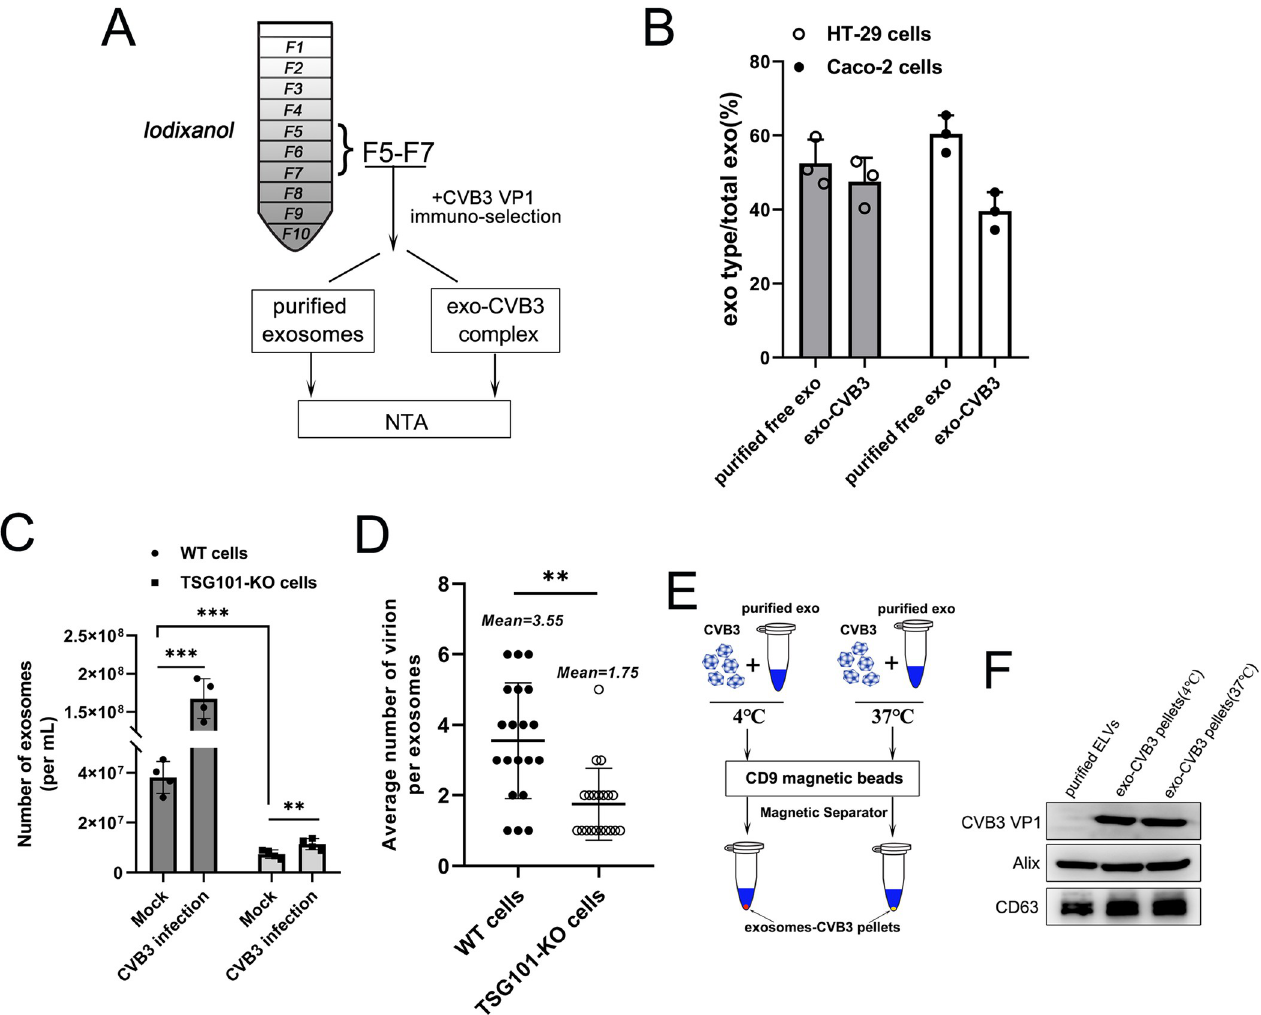
Fig 4. Characterization of exosome-CVB3 attachment. (A and B) The proportion of exosomes-CVB3 complex in total exosomes was determined by NTA. Fractions 5–7 from Optiprep gradient purification were pooled, and subjected to immuno-magnetic selection using VP1 antibody. Different symbols correspond to independent experiments. (C) The numbers of exosomes from WT Caco-2 cells or TSG101-KO Caco-2 cells with or without CVB3 infection was determined by NTA. Culture supernatants was collected from equal number of WT or KO Caco-2 cells at 24h post-infection with a 0.05 TCID 50 of CVB3. (D) Quantitation of CVB3 virion bind with exosomes from images of electron microscopy in WT or KO Caco-2 cells. n = 20 exosomes from three independent experiments. (E and F) CVB3 virion mixed with purified exosomes at 4˚C or 37˚C temperature to form exosomes-virion complex followed by immuno- selection with anti-CD9. The exosomes-CVB3 pellets from different temperature condition were determined using viral anti-VP1 and anti-CD9 through western blot. Data are shown as mean ± SD of three independent experiments. ( �� p < 0.01, ��� p <